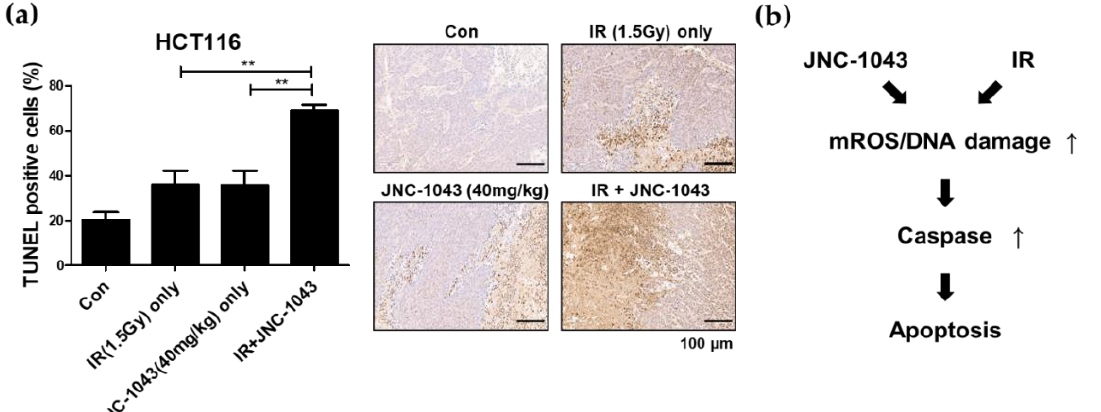
Figure 9. Combination treatment with JNC-1043 and IR inhibits tumor growth in vivo. ( a ) TUNEL assays measuring apoptotic cells in mouse xenografts. Mice injected with CRC cells were divided into four groups: control group, IR-only group (1.5 Gy), JNC-1043-only group (40 mg/kg), and IR+JNC-1043 group (in which mice were pretreated with 40 mg/kg JNC-1043 for 6 h prior to IR). Apoptotic cells in each xenograft were detected by TUNEL assay. The dark brown area in each tissue sample, indicating staining with the TUNEL reagent, was detected using Image J Ver.1.8.0. The graph indicates quantitative analyses of the ratios of TUNEL-stained apoptotic cells to total cells. ‘Con’ , mock control; ‘ IR only ’ , treatment with 1.5 Gy IR only; ‘ JNC-1043 only ’ , treatment with 40 mg/kg JNC-1043 only; ‘ IR+JNC-104 3′ , co-treatment with 1.5 Gy IR and 40 mg/kg JNC-1043. Each bar in the tissue images indicates 10 0 μ m. Experiments were repeated in triplicate, and the results indicate the mean of triplicate assays. ( b ) Schematic diagram showing the radiosensitization effect of JNC-1043. **; p <